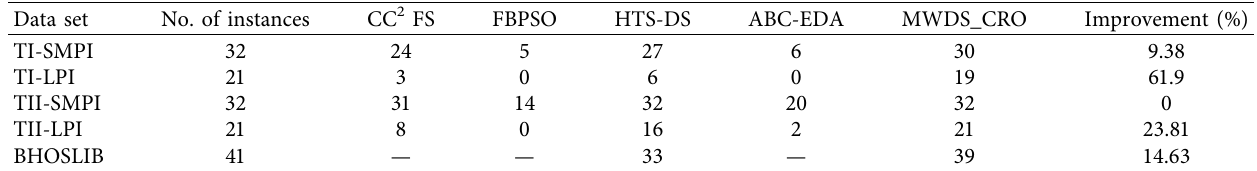
Table 10: Comparison of results with respect to best-known